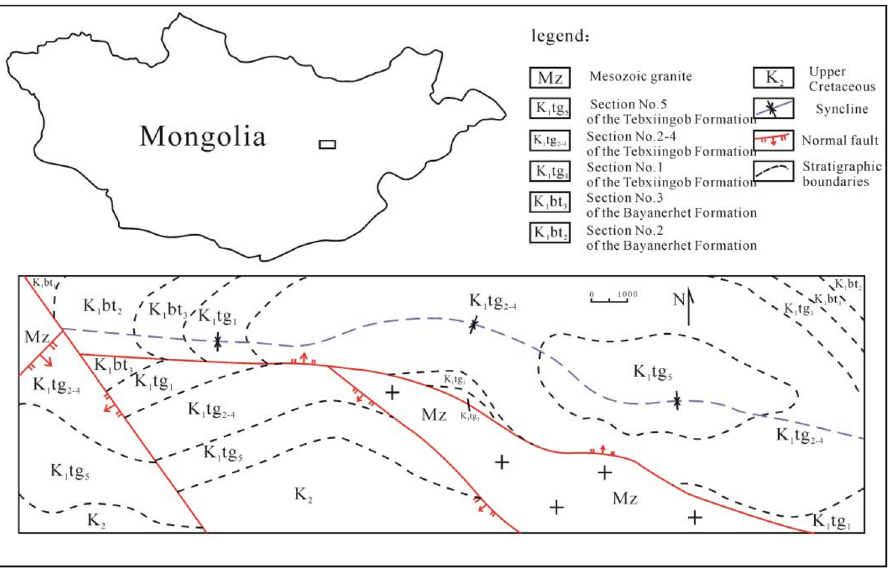
Figure 1. Geological map of the Bayanjargalan